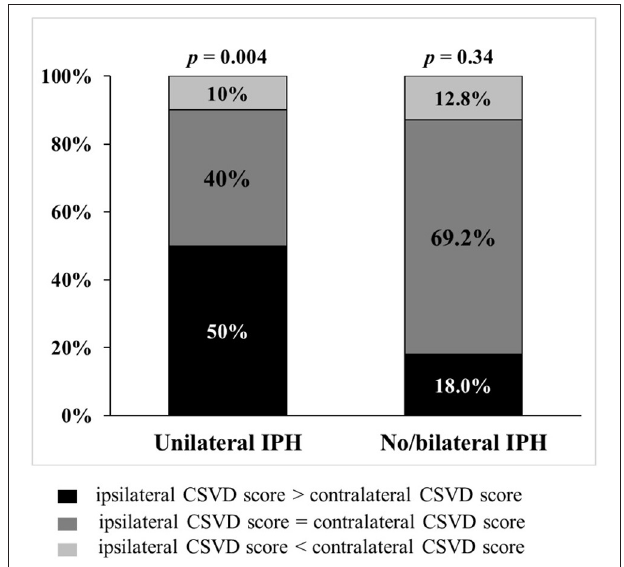
FIGURE 3 | The symmetry of CSVD burden in patients with and without unilateral IPH. In 31 patients with unilateral intraplaque hemorrhage (IPH), the total cerebral small vessel disease (CSVD) scores were higher on the IPH-side ( p = 0.004). In 77 patients with bilateral or non-IPH, CSVD scores were largely similar between ipsilateral and contralateral hemispheres of stenosis ( p =